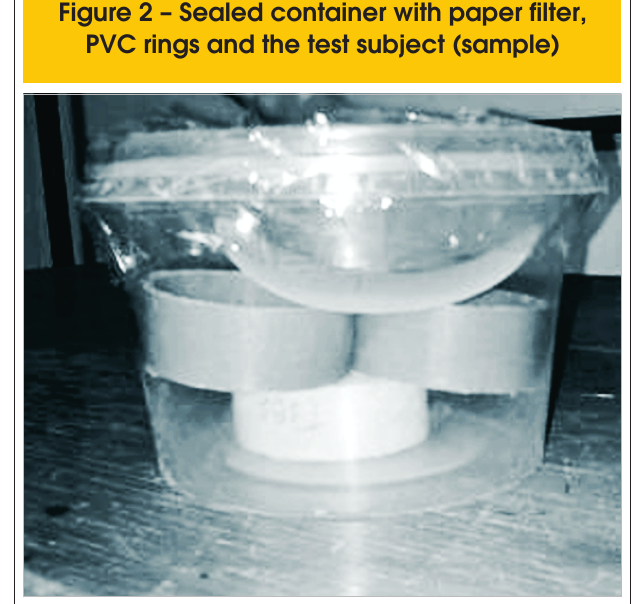
Figure 2 – Sealed container with paper filter, PVC rings and the test subject